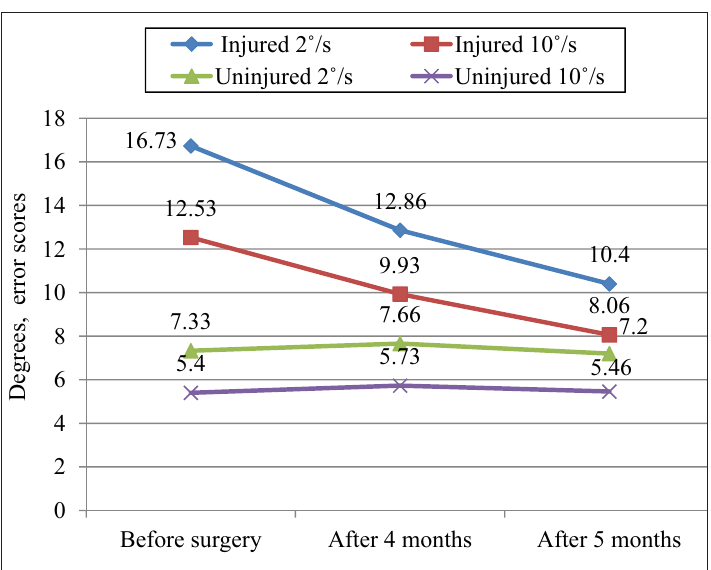
Figure 1. Mean values of uninjured and injured knee extension at different velocities (p <